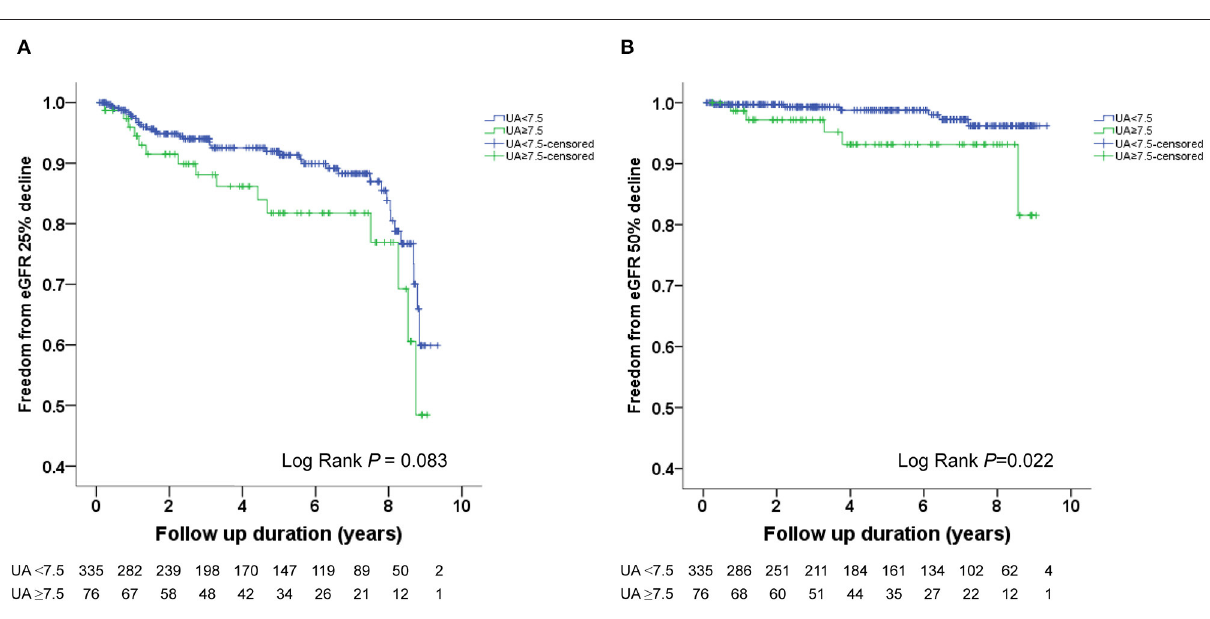
hypertension. Our investigation suggests that hyperuricemia, with a cutoff of 7.5 or 8.0 mg/dL, is related to the decline of renal function in Han Chinese hypertensive patients in